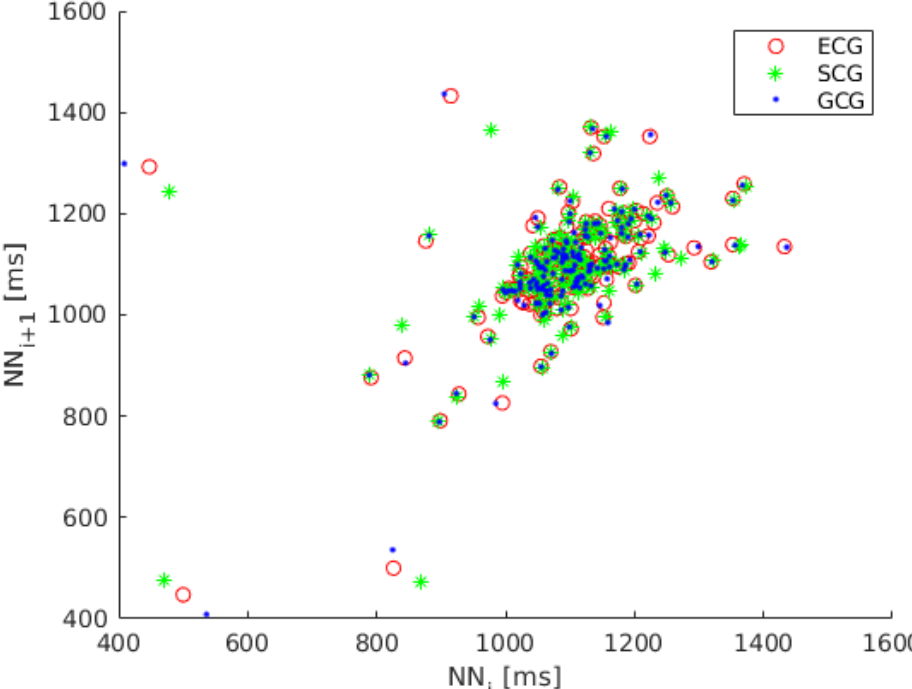
Figure 2. Poincaré map of heart rate variability (HRV) calculated on ECG (red circles), SCG (green asterisks) and GCG signal (blue